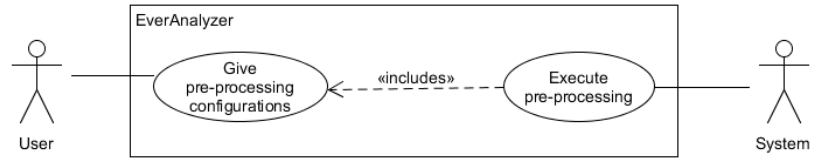
Figure 10. Use Case diagram of EverAnalyzer Objective #4.